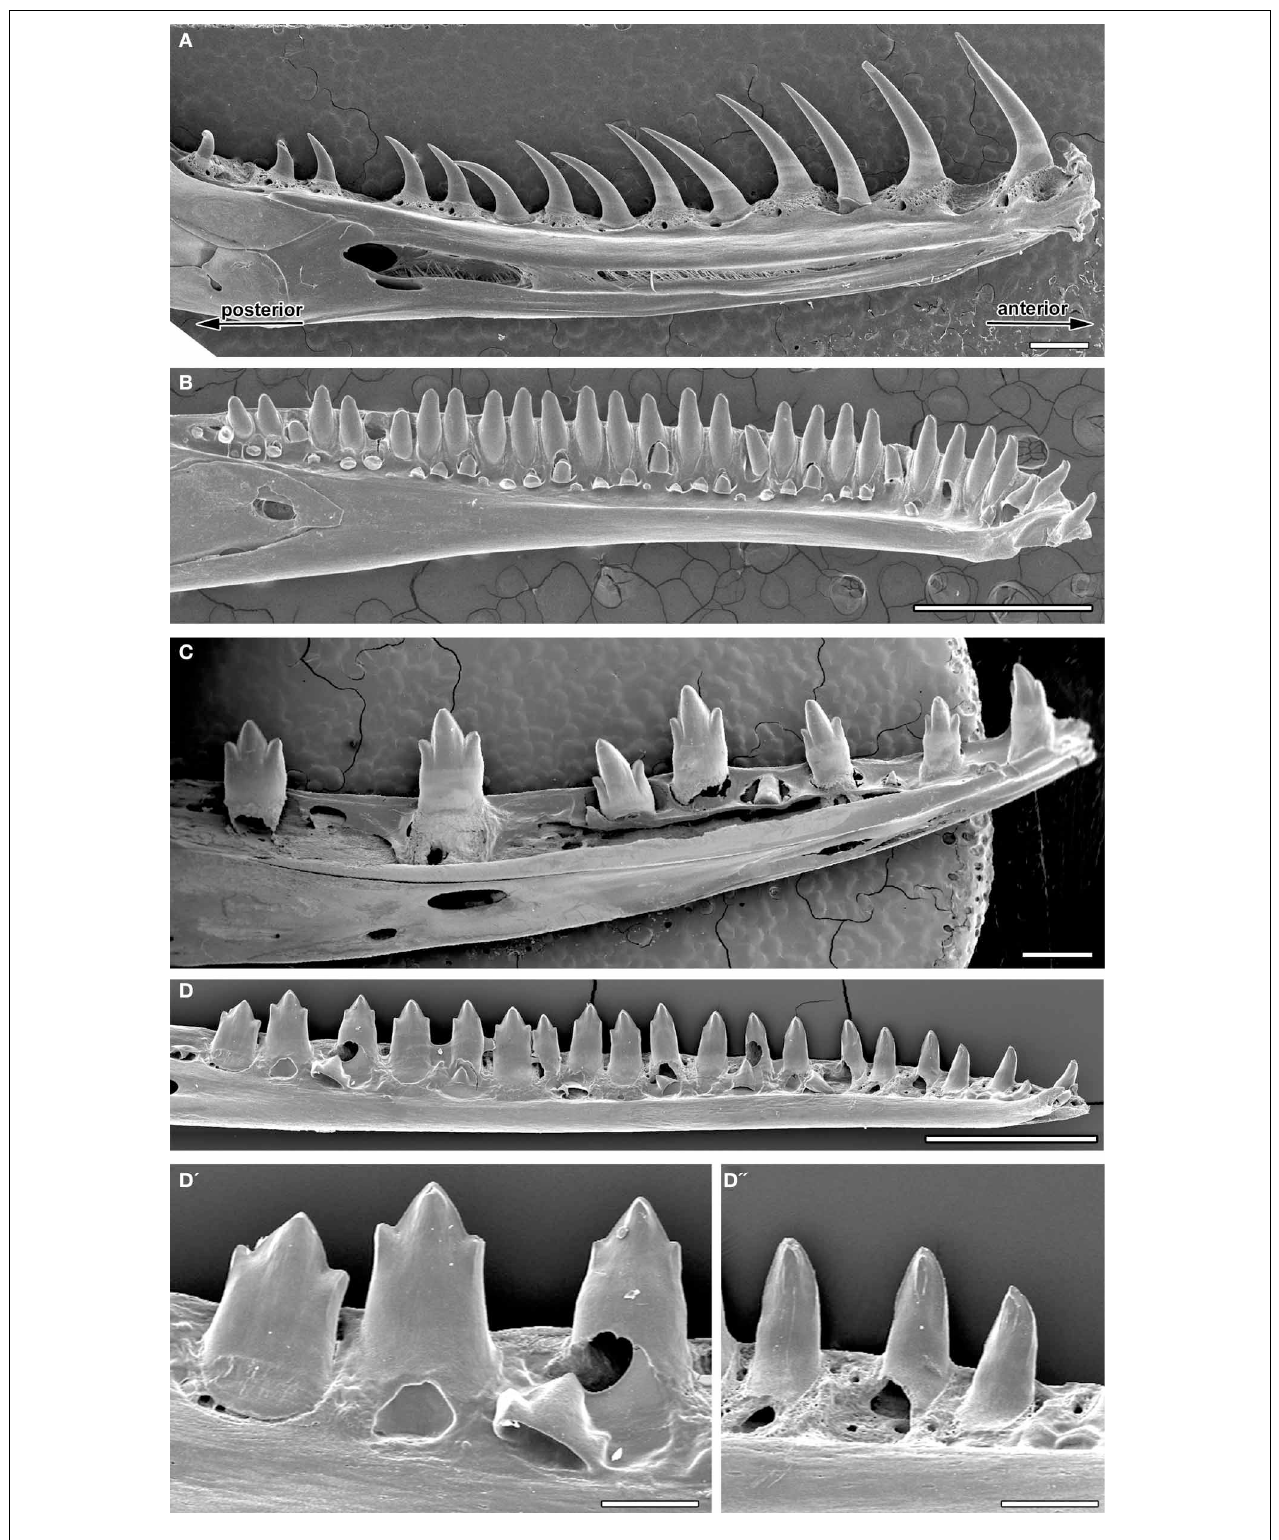
FIGURE 2 | Tooth shape changes within the jaw (heterodont/homodont). SEMs of adult lower jaws. (A) Homodont unicuspid snake, Python molurus , (B) homodont gecko, Paroedura picta , (C) homodont tricuspid Monitor lizard, Varanus niloticus , (D)